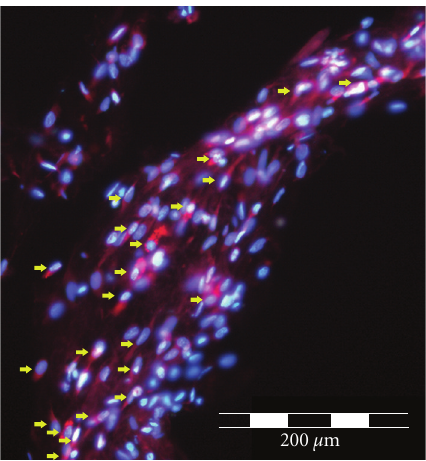
Figure 4: Depicts exemplarily red-fluorescent PKH26-GL cell surface staining of transplanted SCs ( red arrows , costained with DAPI in blue) in a longitudinal cryostat section through the regrown nerve in a silicone tube 3 weeks